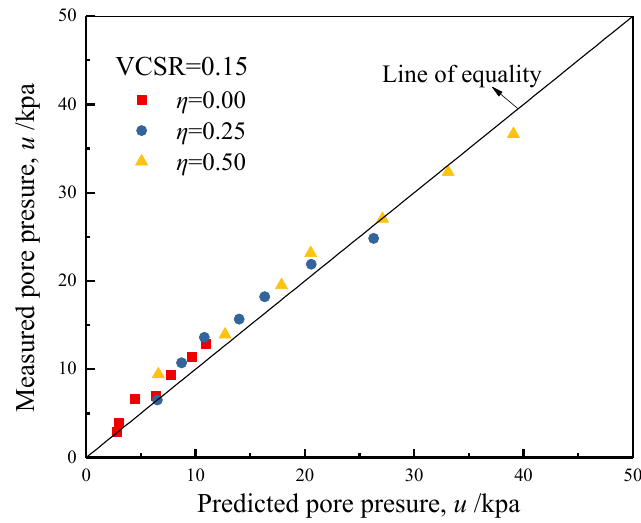
Figure 9. Comparison of predicted and measured pore pressure.